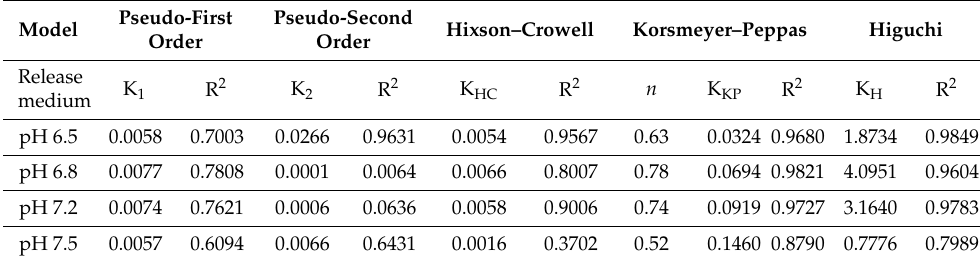
Table 5. Kinetic parameter for drug release from CS-Mn:ZnS nanocomposite fitted to various pharmacokinetics